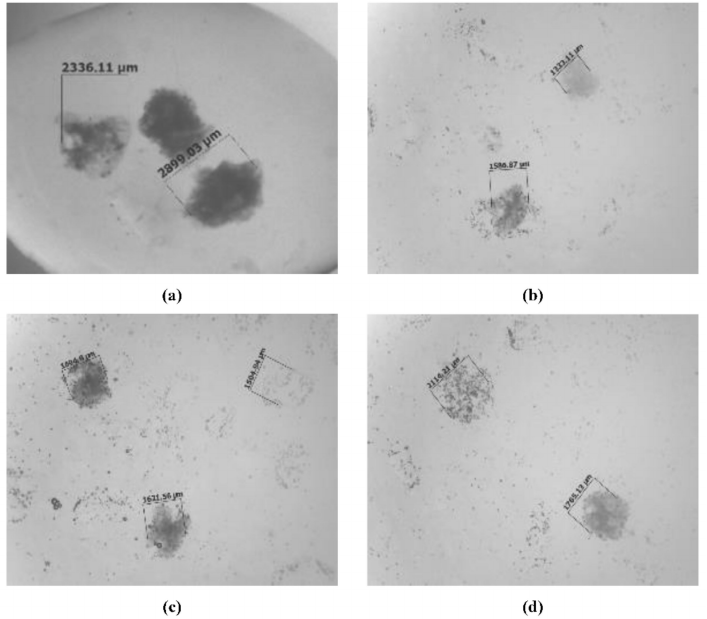
Figure 9. Particle size of polymer AP-P4 dissolved particles with different packing pore sizes. ( a ) unfilled; ( b ) 200 µ m; ( c ) 300 µ m; ( d ) 450 µ